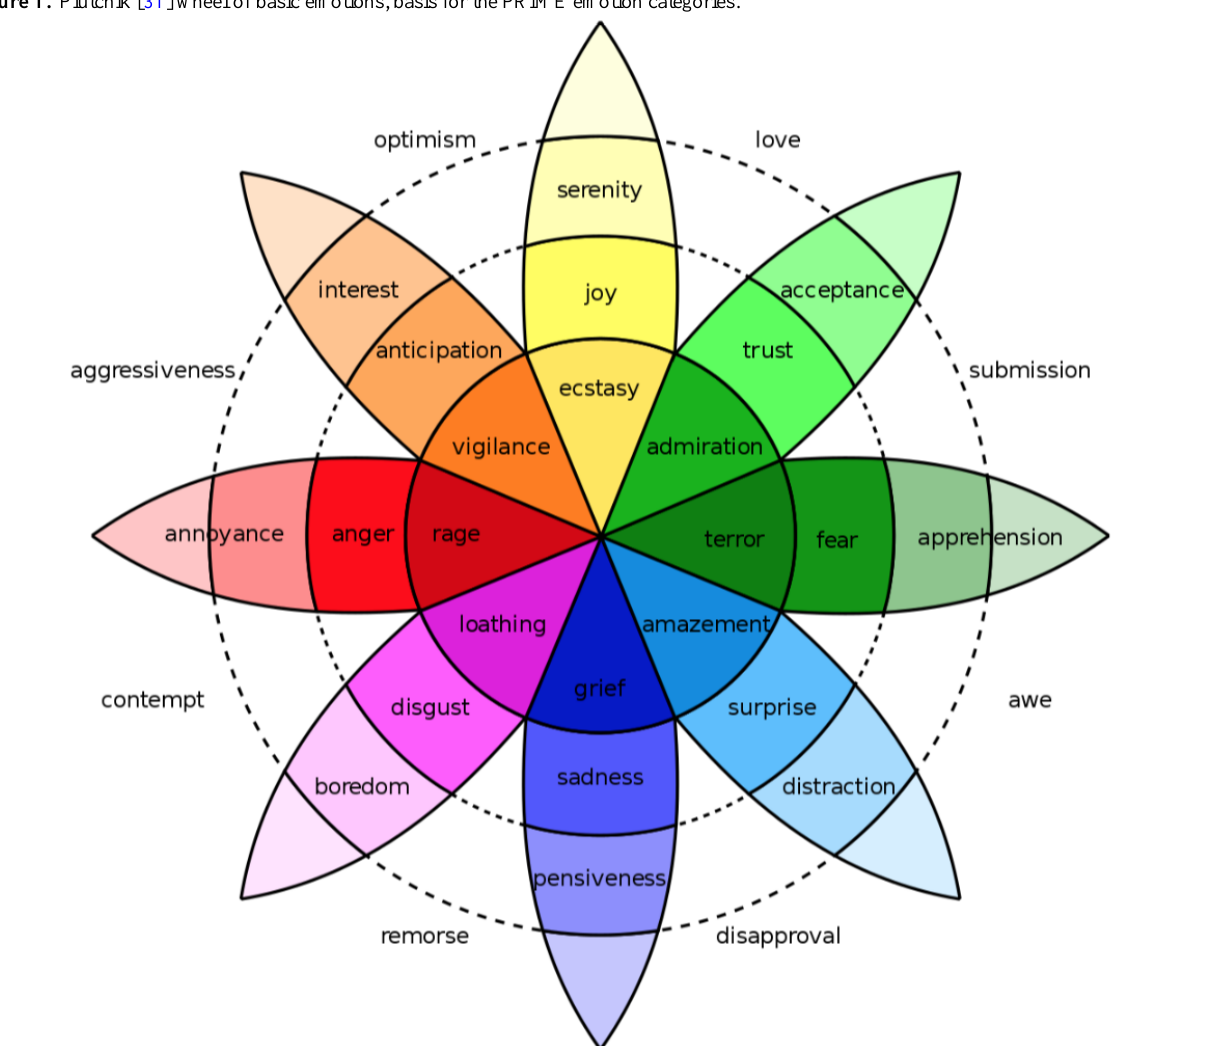
Figure 1. Plutchik [31] wheel of basic emotions, basis for the PRIME emotion